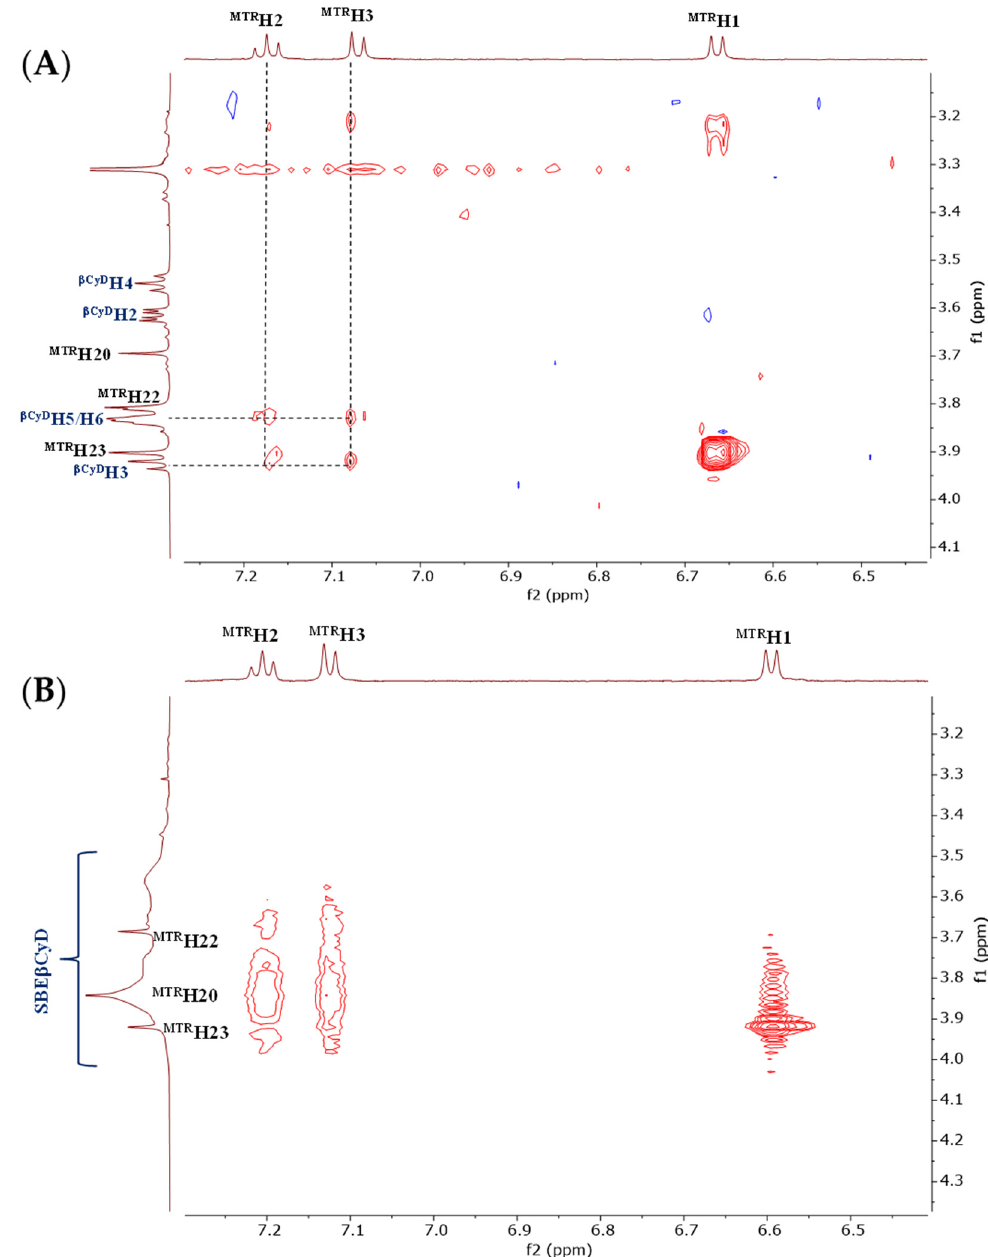
Figure 4. Partial 2D ROESY NMR spectra in the two studied CyD:MTR complexes. Subplot ( A ) (1MTR:2 β CyD) molar ratio showing cross-peaks between the aromatic MTR resonances and the inner cavity resonances (H5 and H3) of the β CyD. Subplot ( B ) (1MTR:2SBE β CyD molar ratio) showing diffuse cross-peaks between the aromatic resonances of MTR and the SBE β CyD protons.